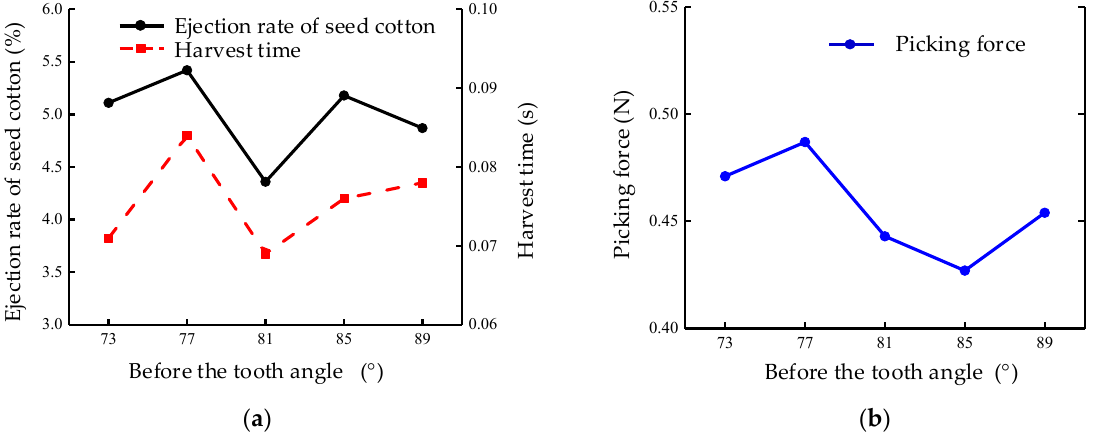
Figure 12. Effect of the tooth angle on the picking performance of the spindle: ( a ) tooth groove angle